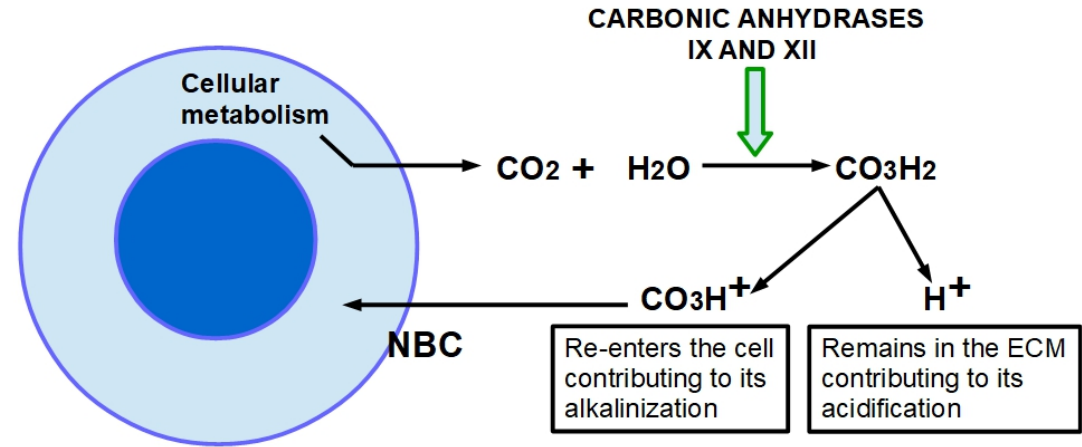
Figure 4. Contribution of carbonic anhydrases to tumor acidification. The cellular metabolism produces an excess of CO 2 that diffuses from the cell into the extracellular space. Membrane carbonic anhydrases IX and XII convert it in carbonic acid (CO 3 H 2 ) through hydration. CO 3 H 2 spontaneously ionizes into a molecule of ionized hydrogen (proton) that remains in the matrix, contributing to its acidification. The bicarbonate ion is reintroduced into the cell through the activity of the sodium bicarbonate cotransporter (NBC) contributing to cytoplasmic alkalinity.